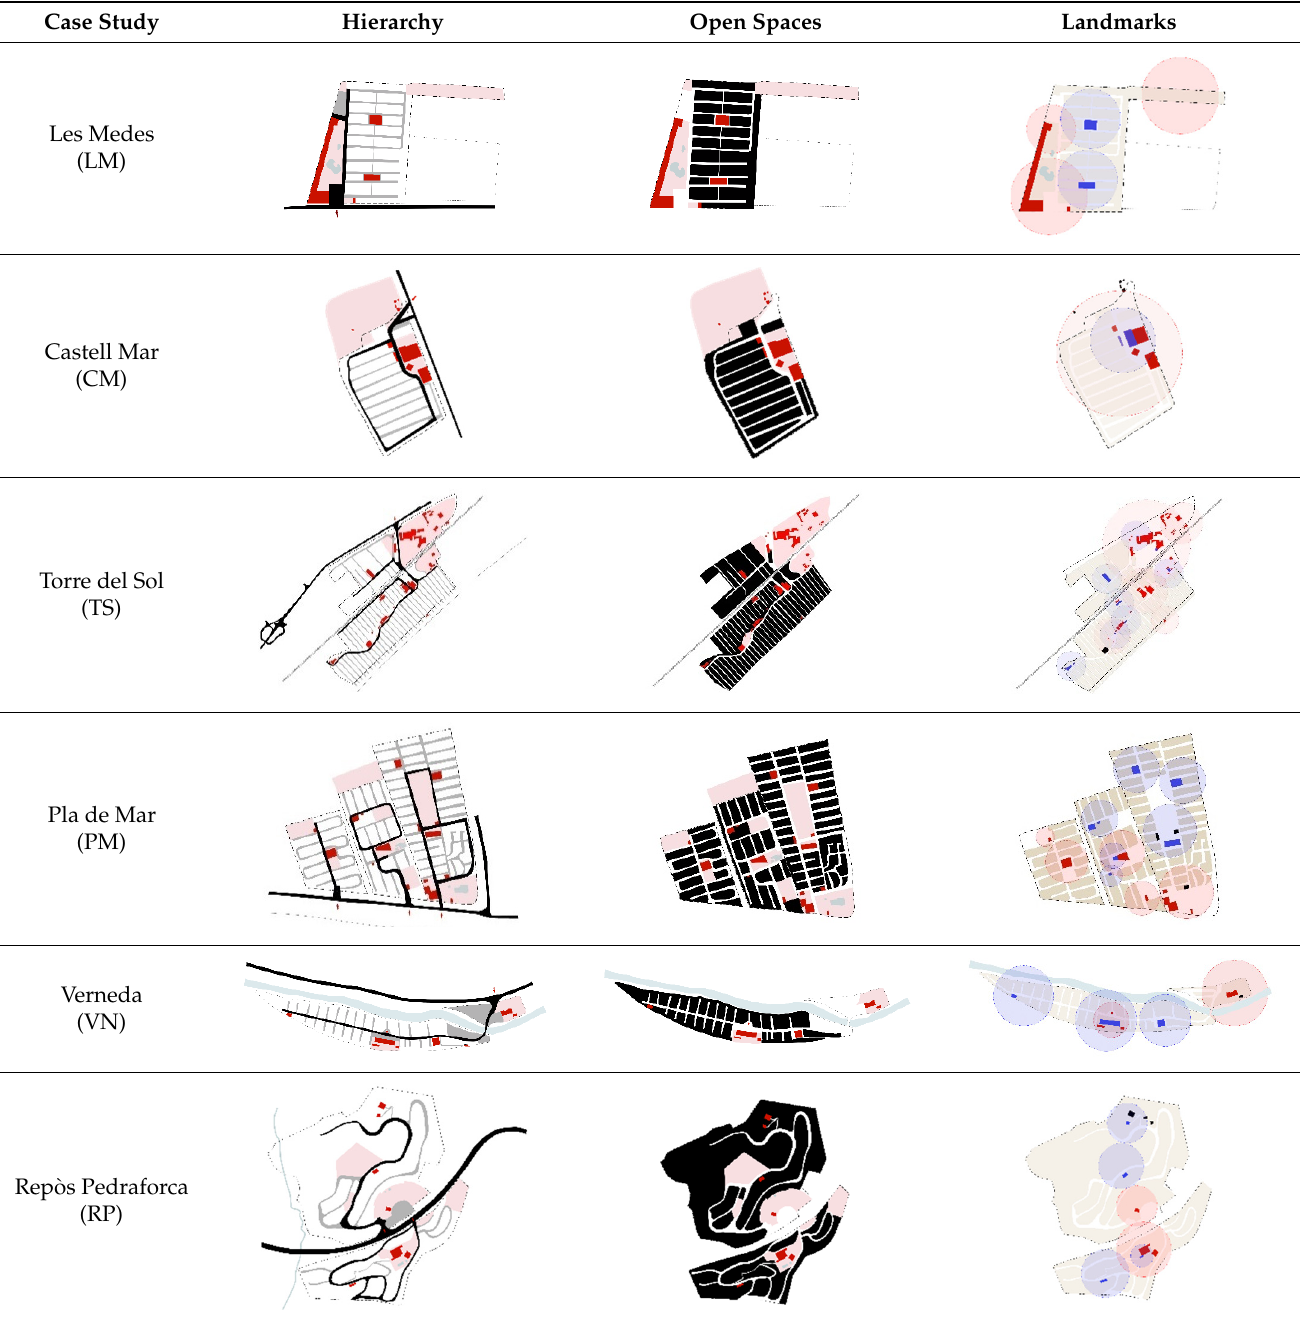
Table 3. Sample of comparative analysis by means of thematic mapping (Source: authors’ own).